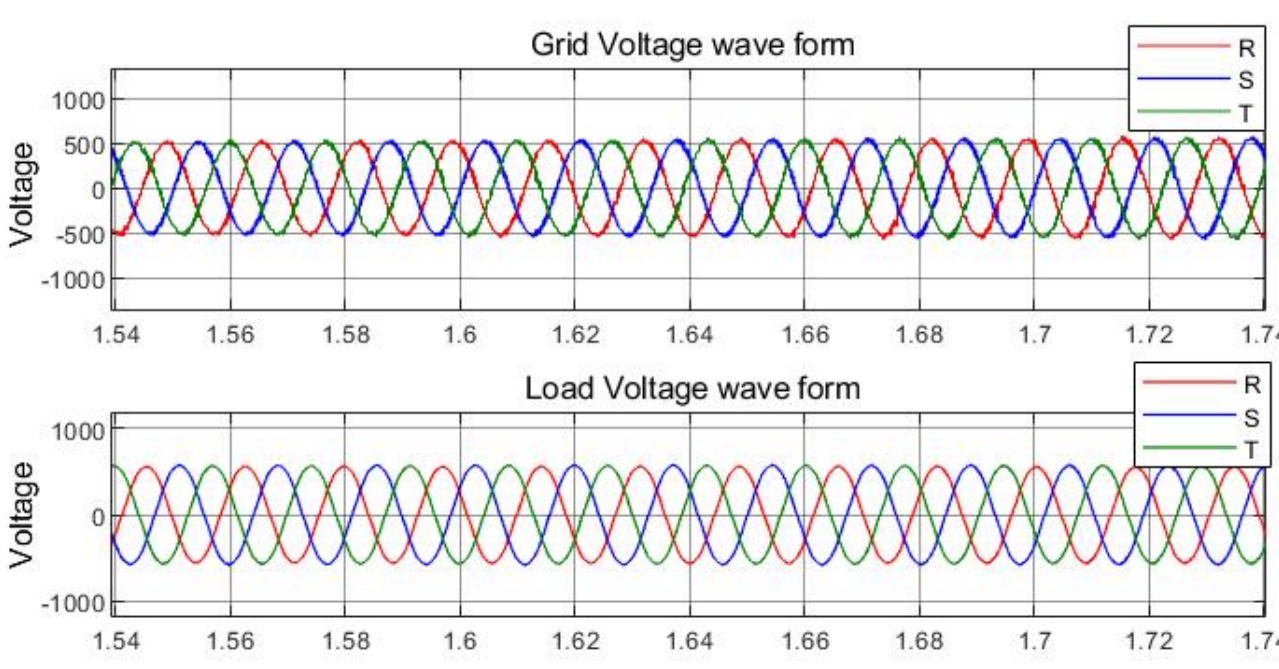
Figure 20. Load ‐ side voltage and grid ‐ side voltage with non ‐ linear load on the load side using hysteresis.